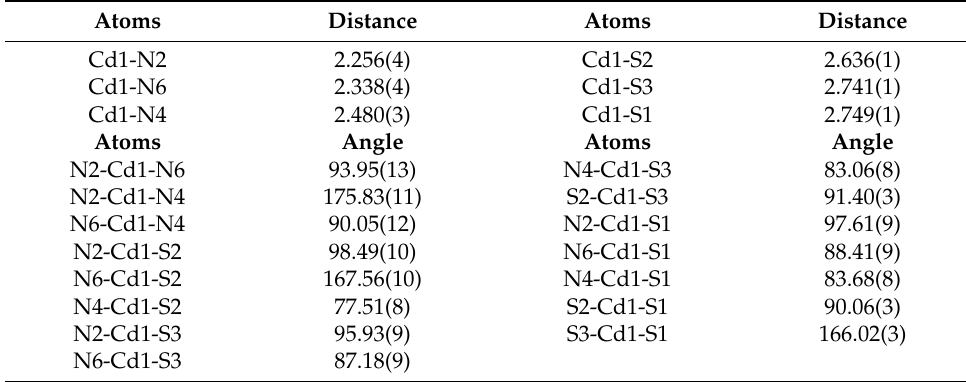
Table 5. The hydrogen bond parameters in 2